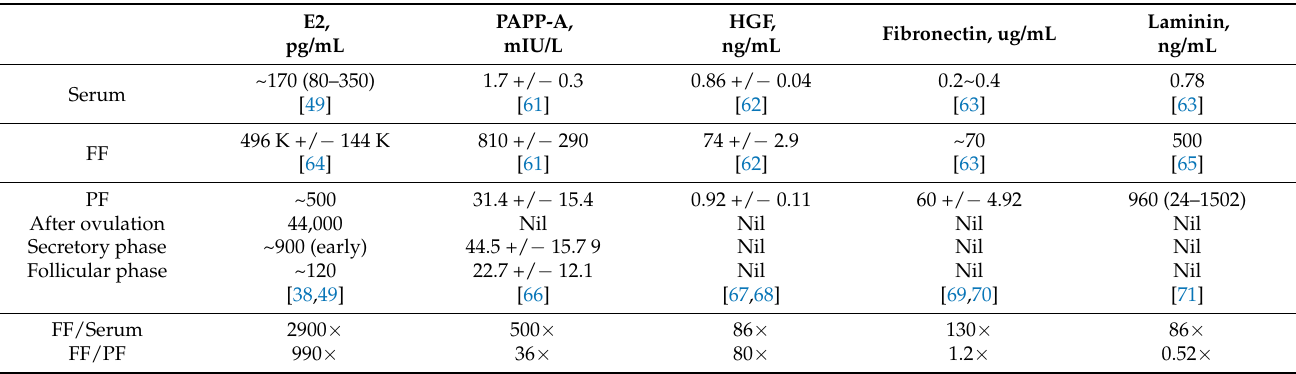
Table 1. Concentration gradients of representative hormones, growth factors, and extracellular matrix proteins in the FF, PF, and